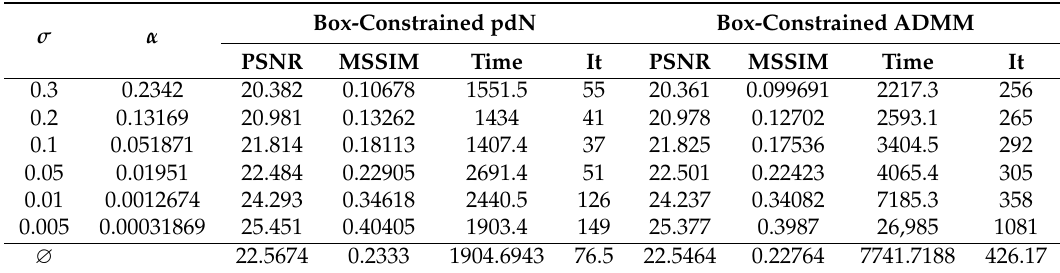
Table 6. Reconstruction of the cameraman-image corrupted by Gaussian blur and Gaussian white noise with standard deviation σ